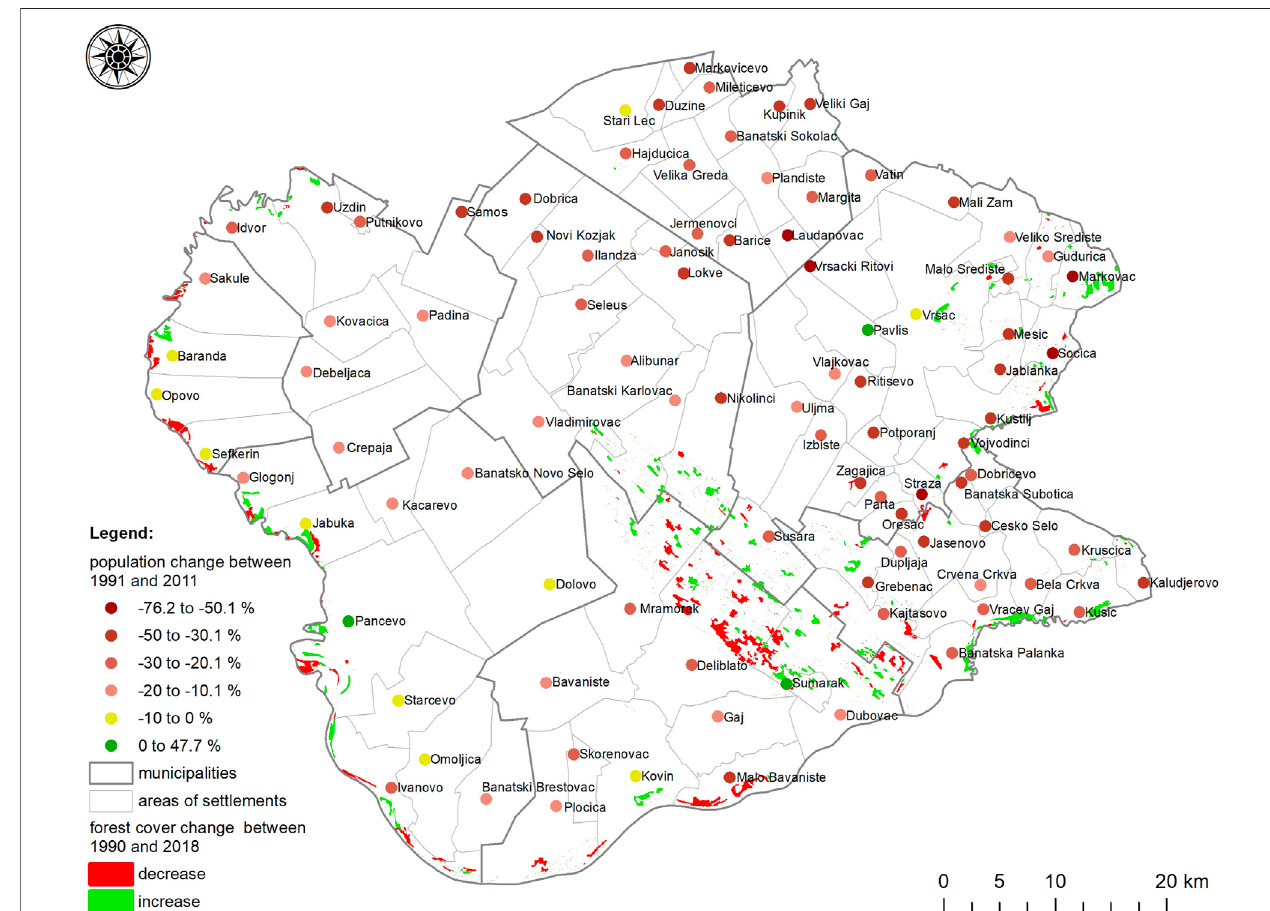
FIGURE 5 | Changes in the number of inhabitants and the forest